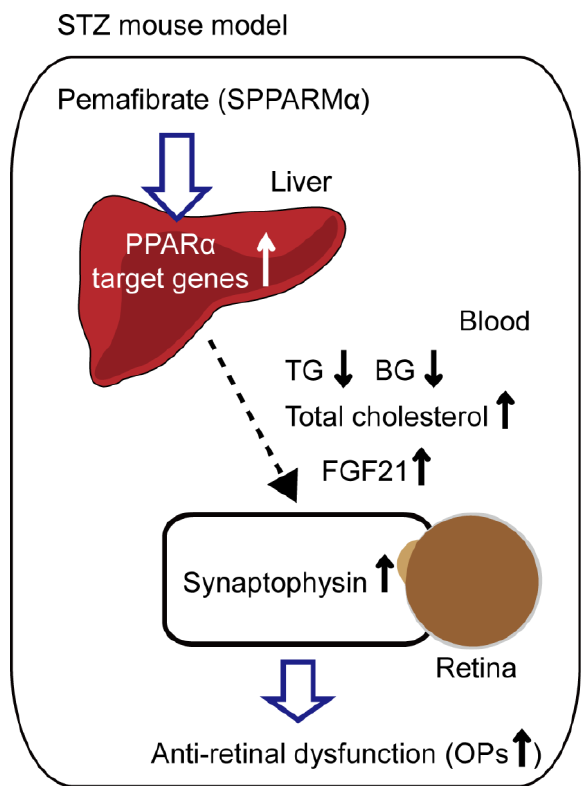
Figure 7. The working hypothesis of the protective mechanism against retinal dysfunction by the administration of pemafibrate in an STZ-induced diabetic mouse model. A possible mechanism for prevention against retinal dysfunction in diabetes is that systemic selective PPAR α modulator (SPPARM α ) pemafibrate administration boosts liver function and upregulates PPAR α target genes in the liver, and an increased level of serum FGF21 improves lipid metabolism by decreasing triglyceride (TG) and increasing total cholesterol levels, mildly decreasing blood glucose level, and finally resulting in an increase in retinal synaptophysin expression and prevention against reduced amplitudes of OPs.